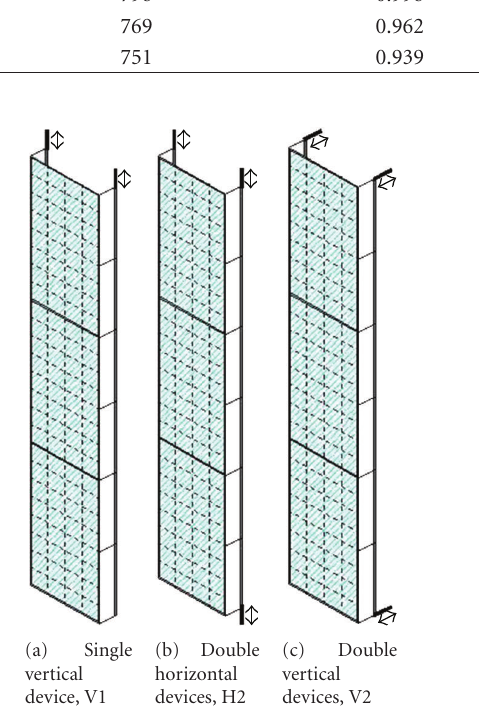
Figure 14: Working scheme of the fac¸ade-module equipped by frictional dissipative devices.